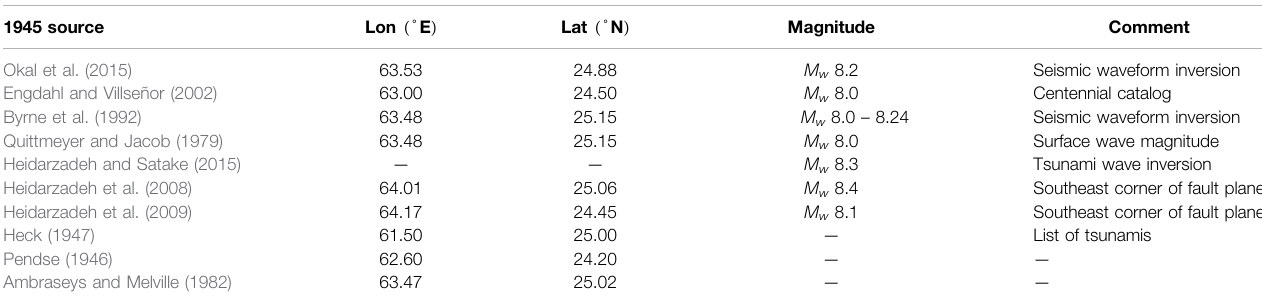
TABLE 1 | Sources from the literature for the 1945 Makran earthquake and